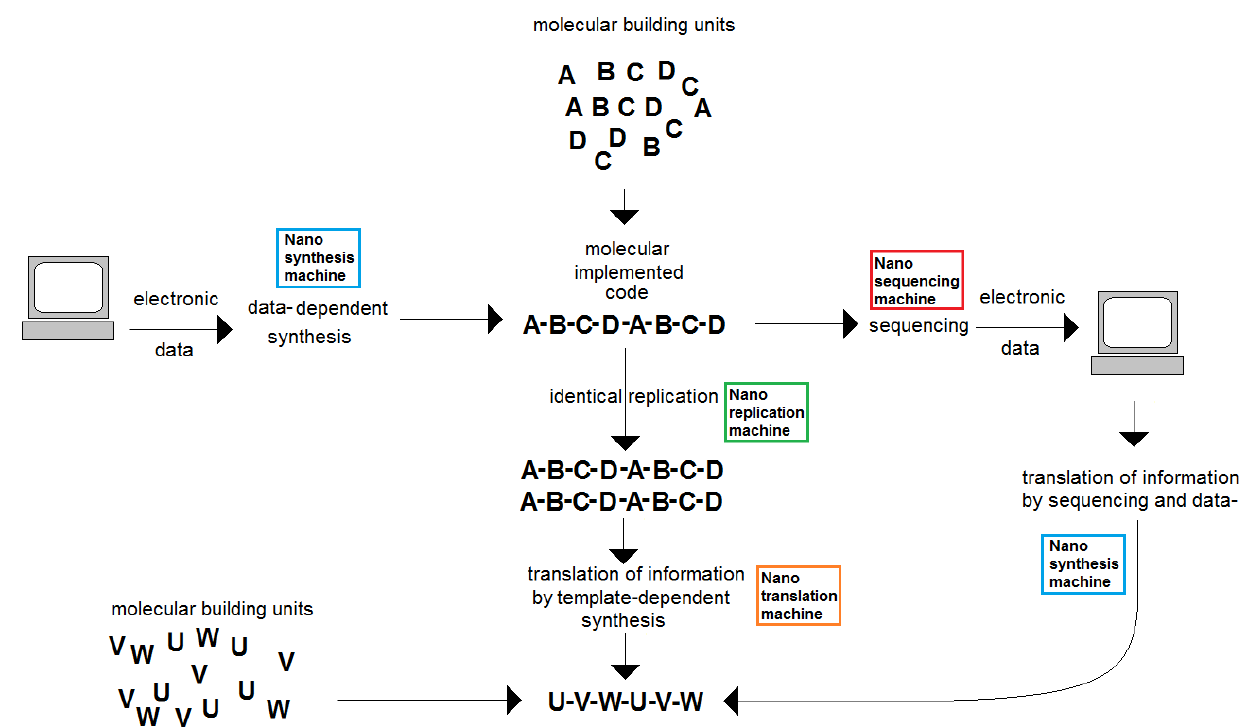
Figure 2. Basic processes for conversion of data and molecular-encoded information and realization and modification of molecular functionality.